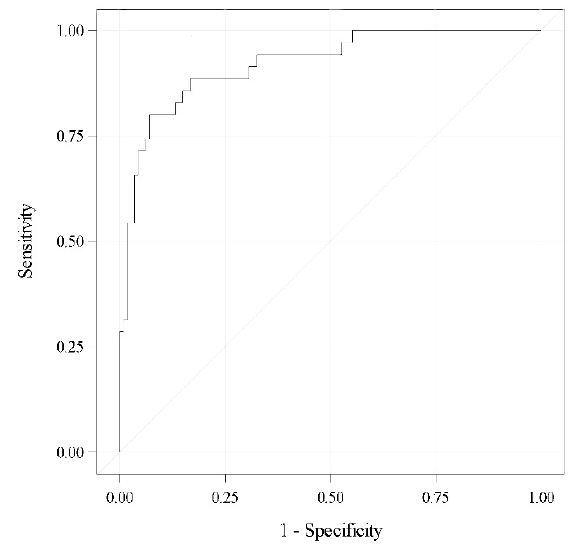
Figure 3. ROC curve for the selected model (AUC 0.92).